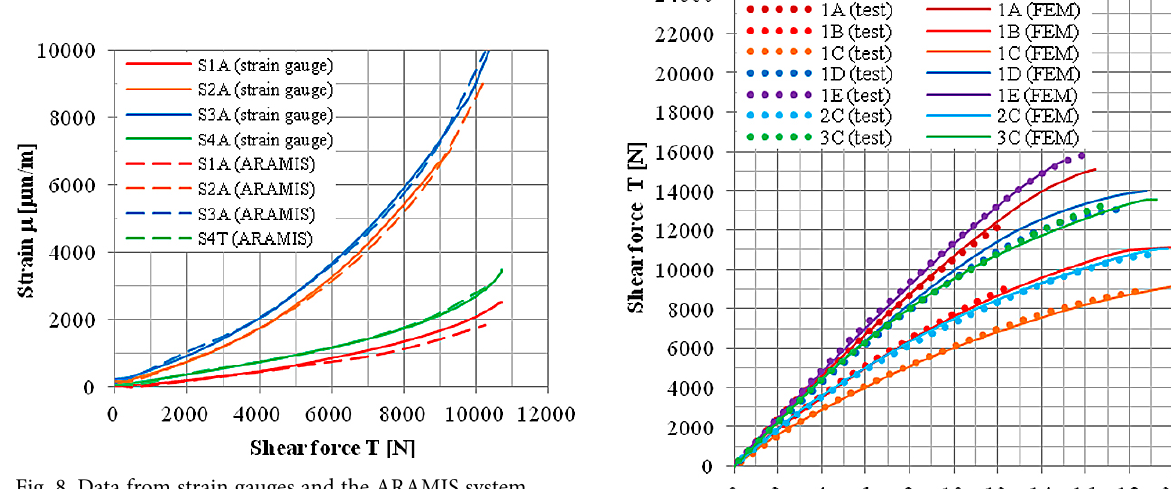
Fig. 8. Data from strain gauges and the ARAMIS system